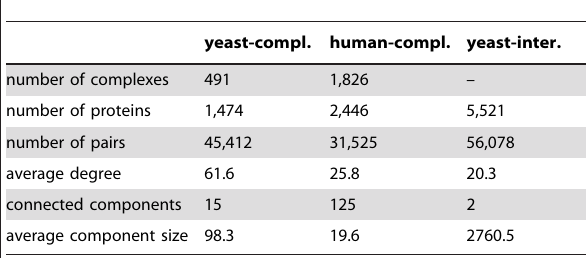
Table 1. Some statistics of the three interaction data